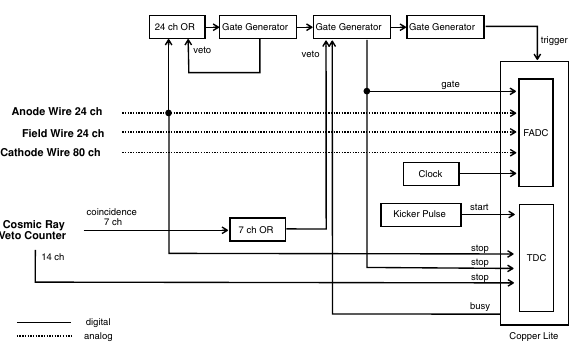
Figure 4. Schematic diagram of the DAQ circuit [16]. The ADC and the TDC operating in the COPPER system [17] are used for taking the data. Wire waveforms of the TPC are recorded by the flash-ADC, whereas timing of waveforms, kicker pulse, and cosmic ray veto counters are recorded by the TDC. Table 2. Physics data set.